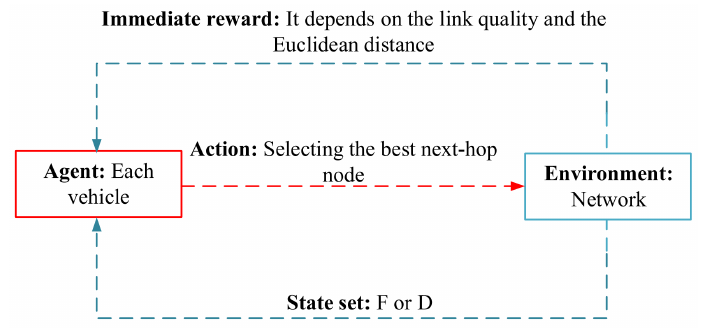
Figure 14. Learning structure in